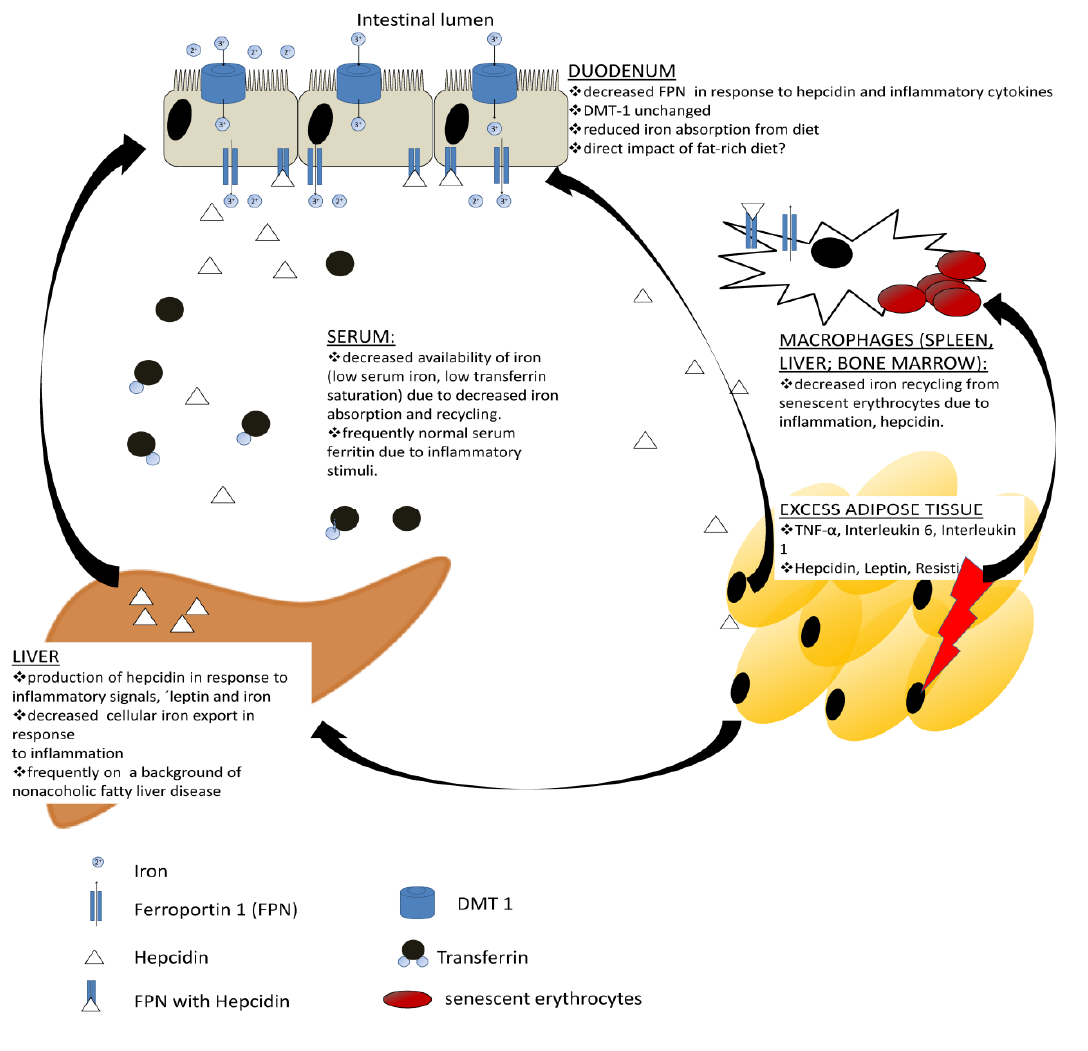
Figure 2. Current understanding of molecular links between obesity and iron deficiency. Obese adipose tissue is characterized by an increased production of several pro-inflammatory cytokines and adipokines as opposed to healthy lean adipose tissue. These may directly impact iron absorption from the enterocyte. Additionally, pro-inflammatory cytokines such as interleukin-1 and -6 represent potent inducers of hepcidin production in the liver, which may further impair iron absorption. Both cytokines and hepcidin lead to iron retention in spleen, liver or bone marrow macrophages, thereby lowering serum iron concentrations and iron availability for